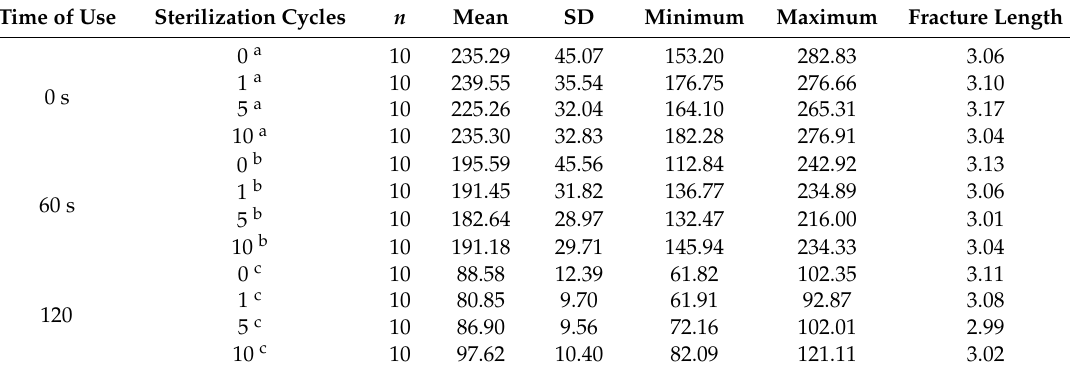
Table 1. Descriptive analysis of the time to failure in relation to time of use and number of sterilization